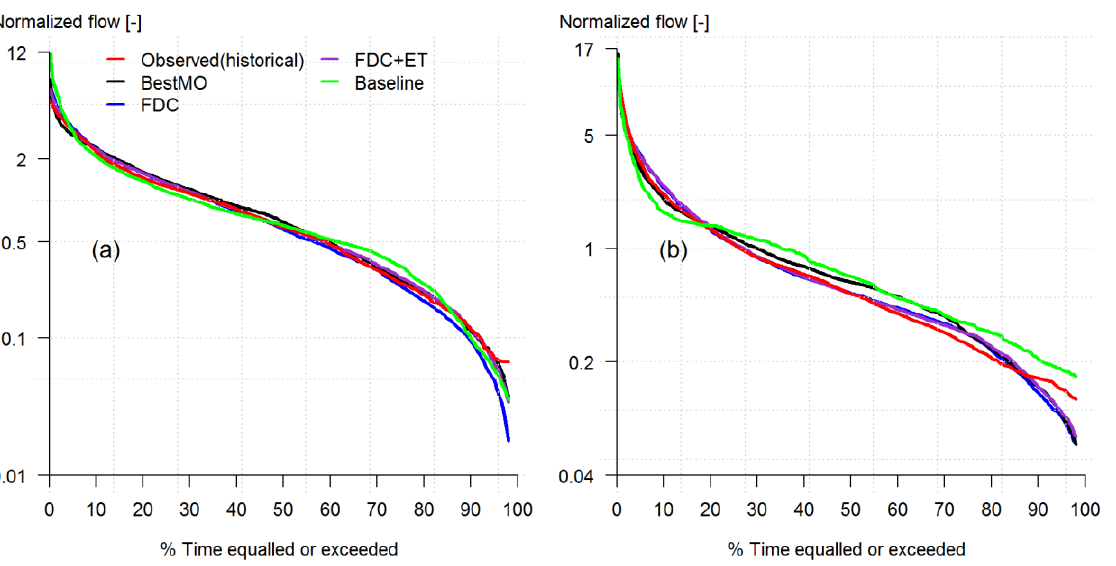
Figure 5. Comparison of normalized mean annual flow duration curves for simulated (2002 – 2007) and observed (1970 – 1990) streamflow for the Nyangores River at Bomet ( a ) and the Mara River at Mara Mines ( b ) using different calibration strategies: uncalibrated (baseline), manually calibrated using only streamflow signatures (FDC) and coupled with evapotranspiration (FDC + ET), auto- matic multi-objective calibration (bestMO). Note that the y-axis is in log scale.